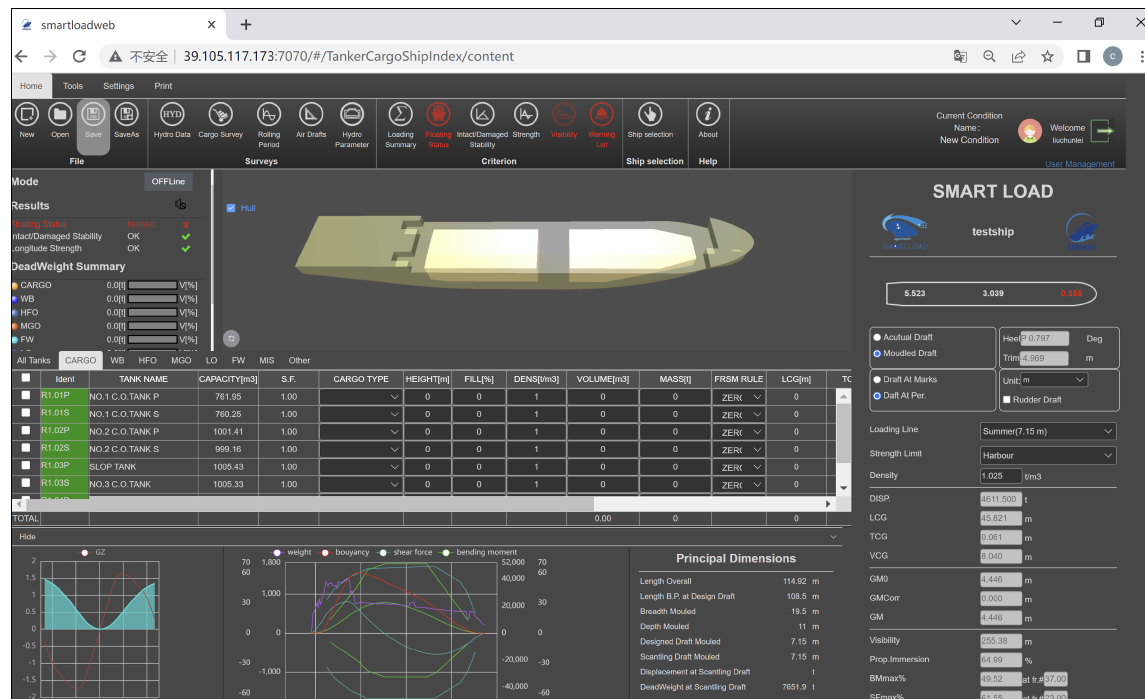
Figure 15. “SMART LOAD” loading computer for the tanker “TAI HUA WAN”.